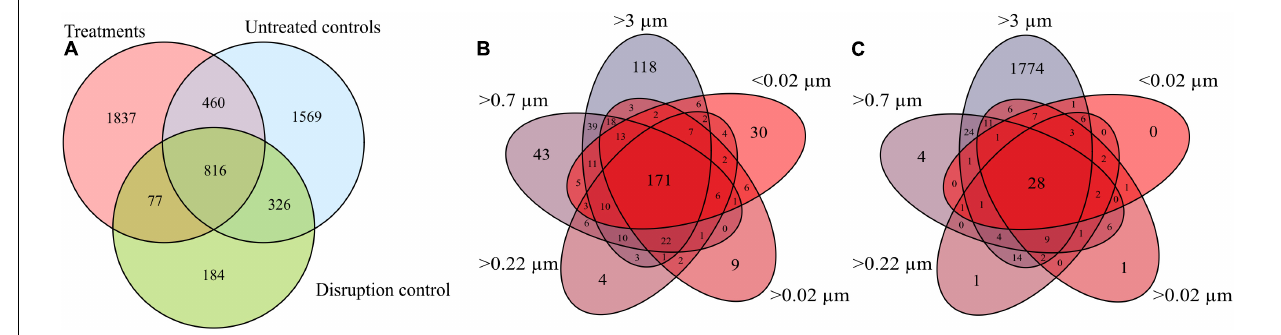
Frontiers in Microbiology |